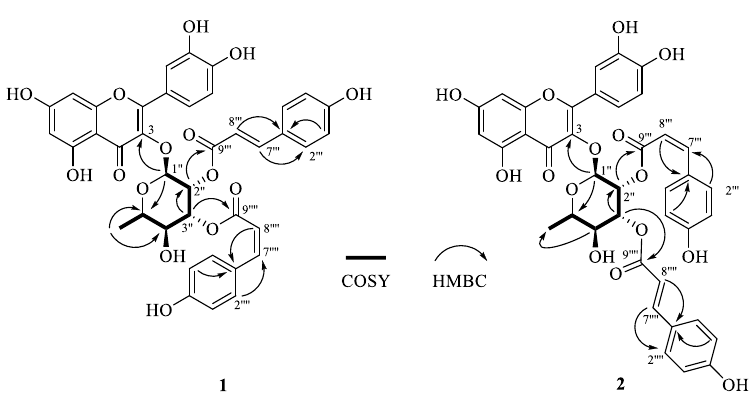
Figure 2. Key 2D (COSY and HMBC) NMR correlations of compounds 1 and 2 . Compound 2 exhibited the same molecular formula (C 39 H 32 O 15 ) as 1 based on the Table 1. NMR spectroscopic data (in CD 3 OD) for compound 1 . HRESIMS data (Figure S13). A comparison of the NMR data of 2 (Table 2) with those of 1 showed the very much close structural similarity between the two compounds. Differing from 1 , the bonding positions of the ( E )- and ( Z )- p -coumaryl units with the rhamnose were found to be swapped upon closer inspection of the HMBC spectrum of 2 (Figure 2), with the ( E )- p -coumaryl unit connecting to C-3”, while ( Z )- p -coumaryl unit connecting to C-2”. Thus, compound 2 was identified as quercetin-3 -O - α -(2”- Z-p -coumaroyl-3”- E-p -